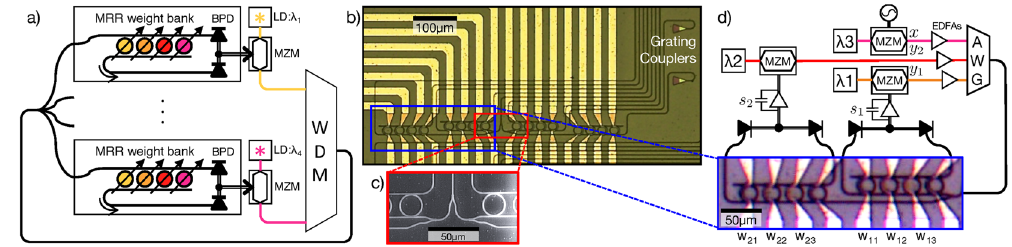
Figure 1. Broadcast-and-weight protocol and experiment. ( a ) Concept of a broadcast-and-weight network with modulators used as neurons. MRR: microring resonator, BPD: balanced photodiode, LD: laser diode, MZM: Mach-Zehnder modulator, WDM: wavelength-division multiplexer. ( b ) Micrograph of 4-node recurrent broadcast-and-weight network with 16 tunable microring (MRR) weights and fiber-to-chip grating couplers. ( c ) Scanning electron micrograph of 1:4 splitter. ( d ) Experimental setup with two off-chip MZM neurons and one external input. Signals are wavelength-multiplexed in an arrayed waveguide grating (AWG) and coupled into a 2 × 3 subnetwork with MRR weights, w 11 , w 12 , etc. Neuron state is represented by voltages s 1 and s 2 across low- pass filtered transimpedance amplifiers, which receive inputs from the balanced photodetectors of each MRR weight